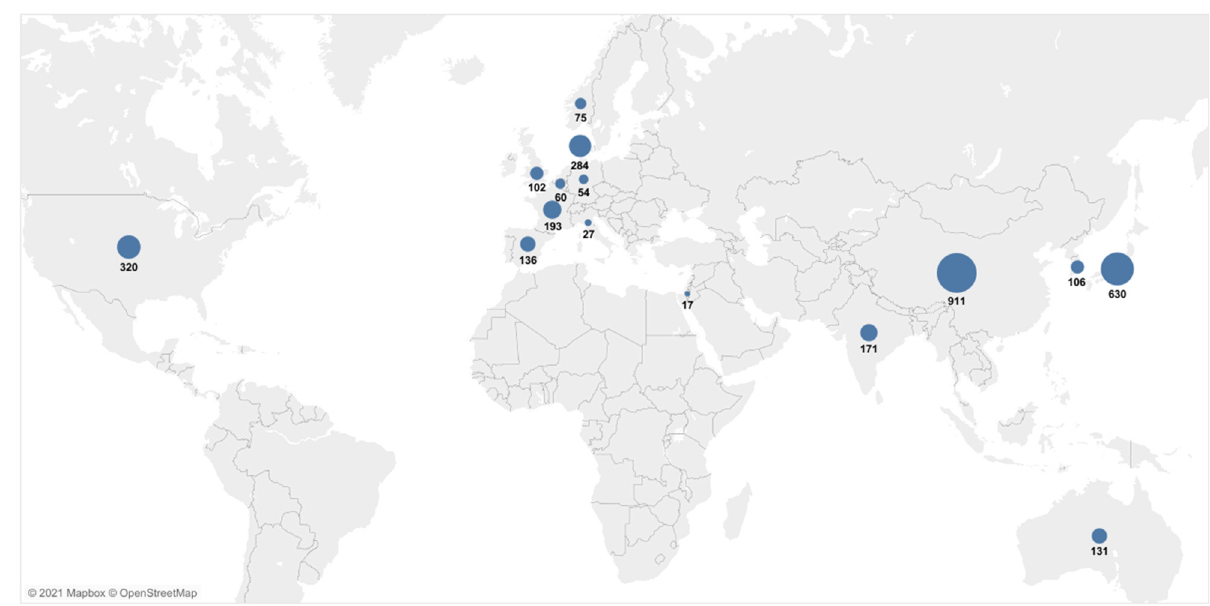
Figure 2. Geographical overview of the patient cases included in the meta-analyses. Data from multicenter and multicountry studies were excluded.